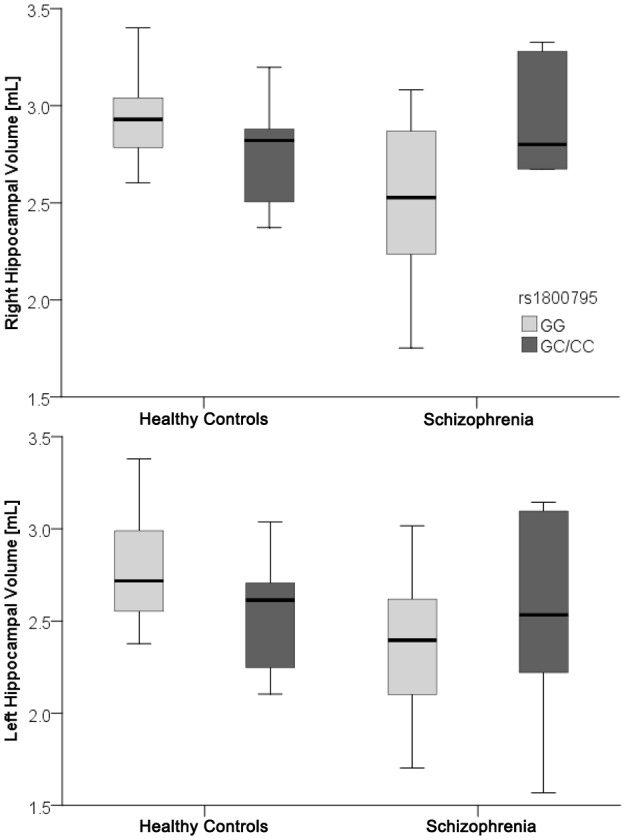
Box plot depicting significant diagnosis-by-genotype interaction on hippocampus volume between patients and controls.Figure shows box plot depicting significant diagnosis by genotype interaction involving both right and left hippocampal volumes – i.e. the effect of rs1800795 genotypes [GG & GG/GC] on hippocampal volume was found to be antithetical between patients and controls; the interaction boxplot shows the five statistics of hippocampal volume (minimum, first quartile, median, third quartile, and maximum) for each genotype per group.